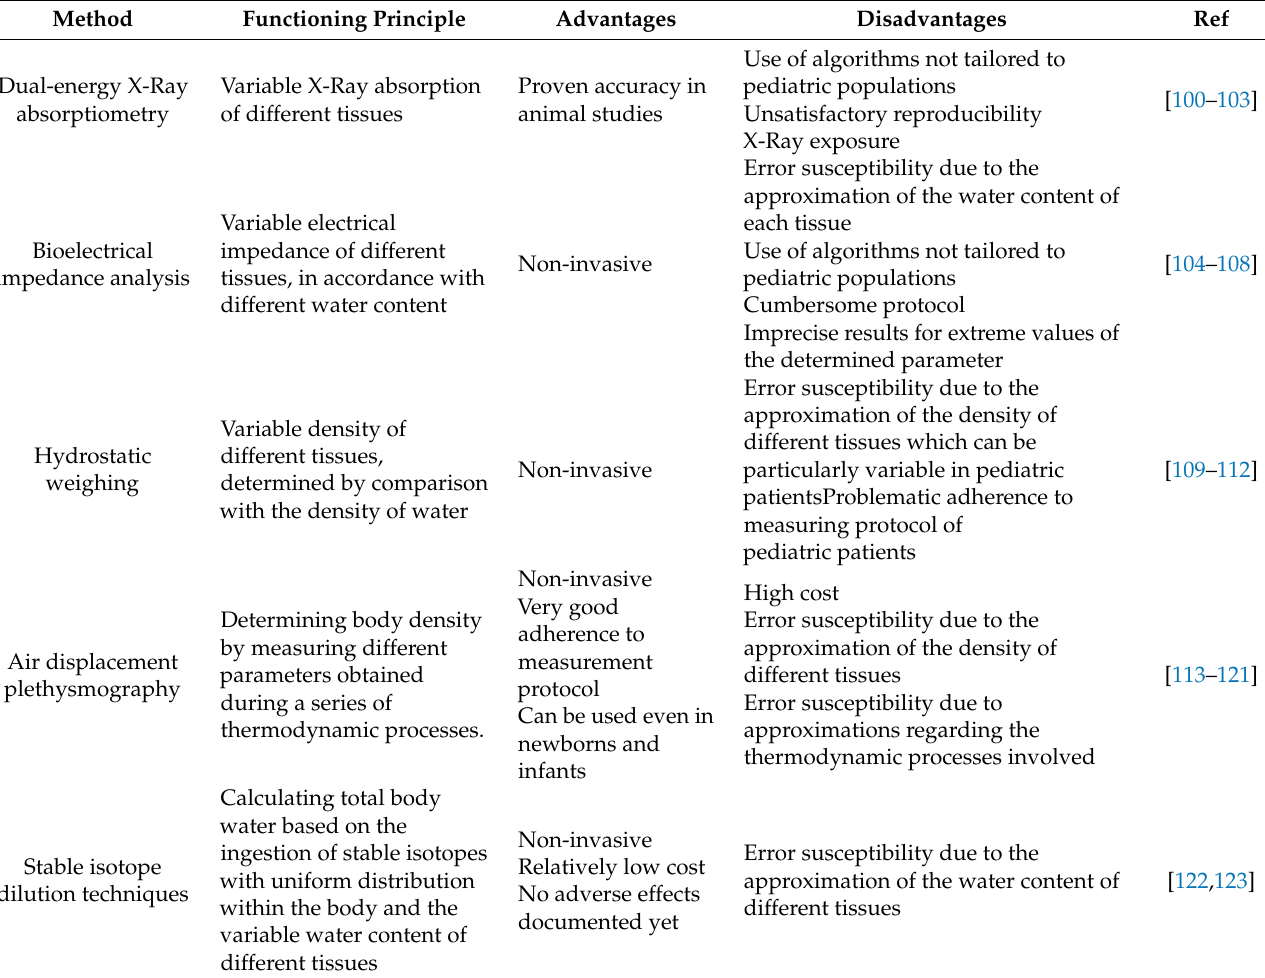
Table 2. Methods of determining body composition.